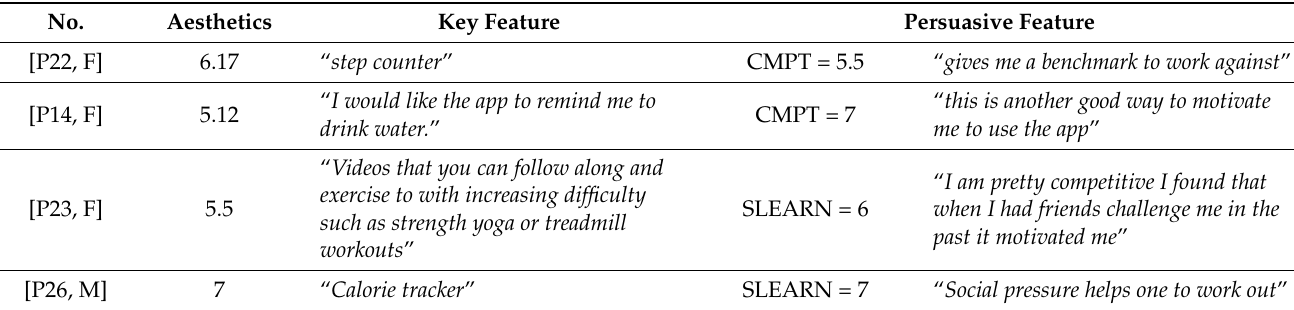
Table 10. Sample comments on the relationship between perceived aesthetics and receptiveness to Competition and Social Learning, CMPT = Competition, SLEARN = Social Learning.